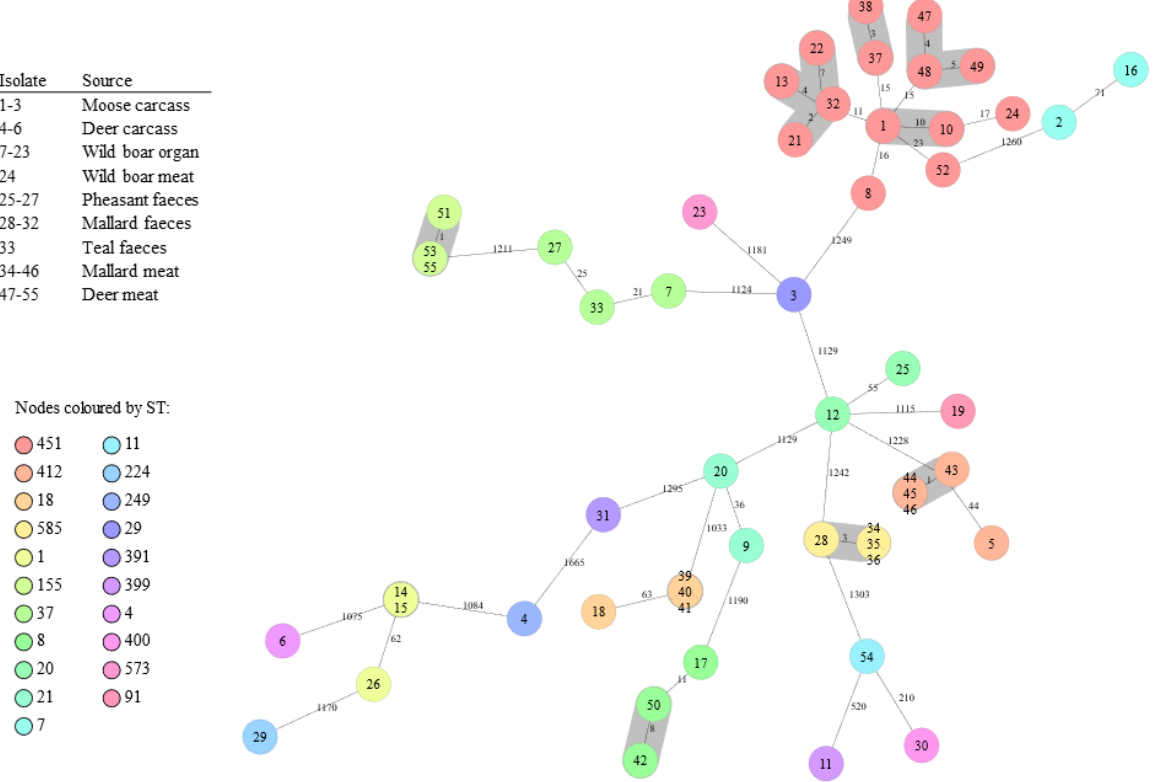
Table 4. Distribution of different serogroups (SGs), MLST (STs) and cgMLST (CTs) profiles, clusters (CLs) and virulence profiles (VPs) among 55 Listeria monocytogenes isolates from hunted game and game meat between 2012 and 2020 in Finland.